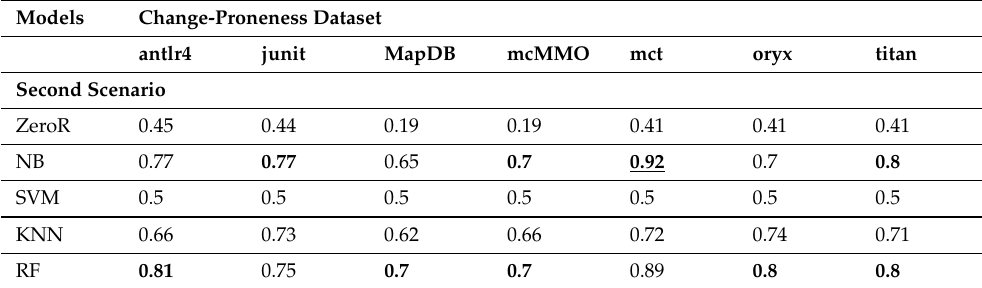
Table 13. AUC values for performance evaluation of prediction models across seven datasets in the second scenario.